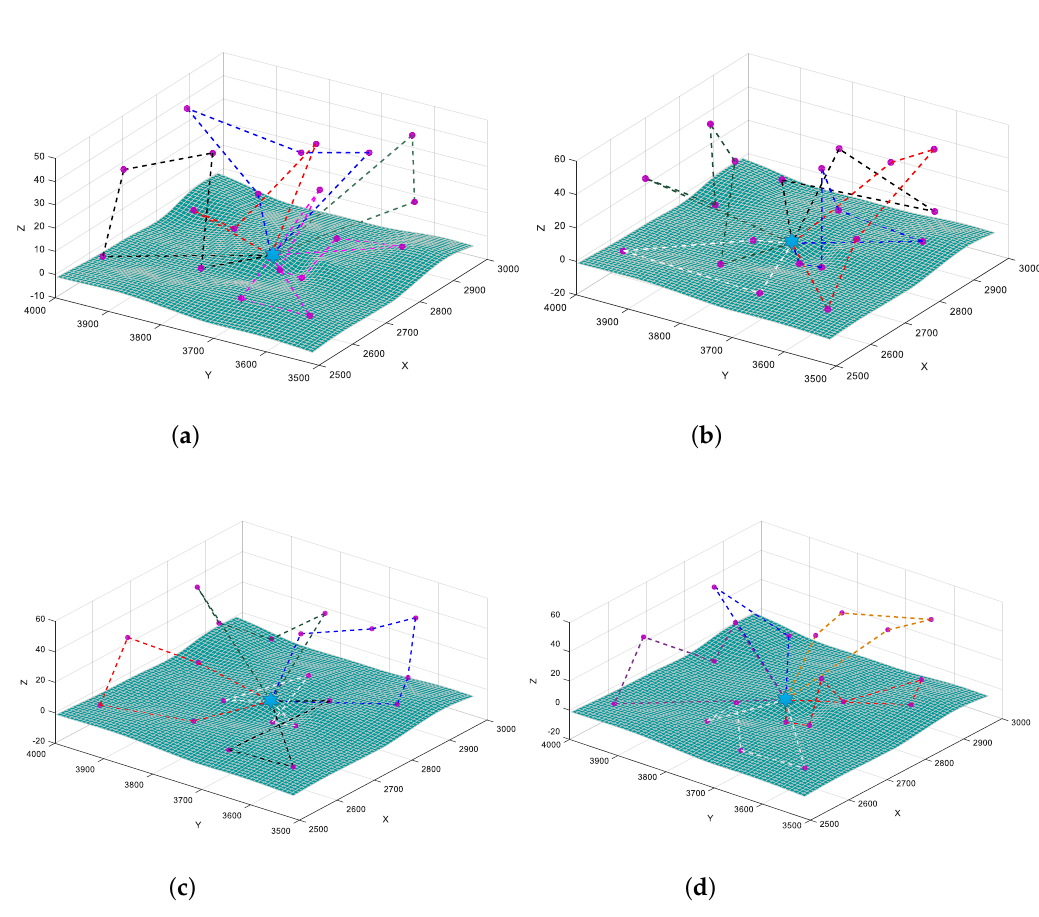
Figure 9. Comparison of optimized results by different methods in scenario C (M = 5, N = 20). ( a ) Optimized result of DIDE (best/1); ( b ) optimized result of MGA ( Rate m = 0.55); ( c ) optimized result of DISA; ( d ) optimized result of